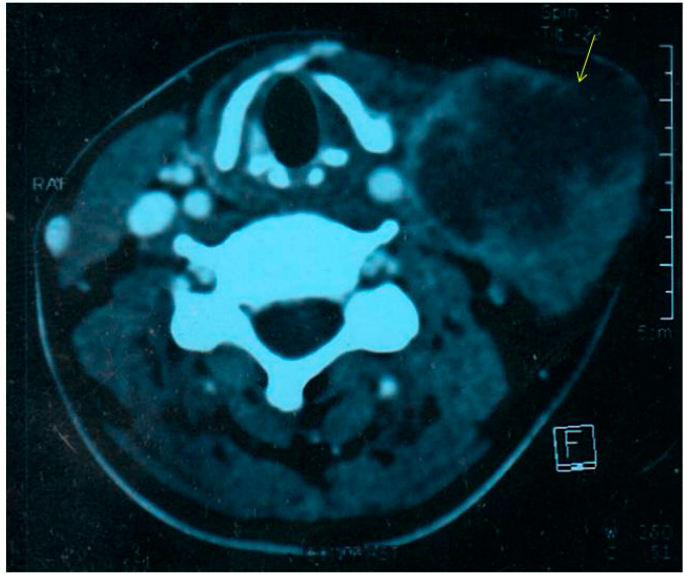
Figure 1. Contrast-enhanced CT neck showing left cervical abscess.